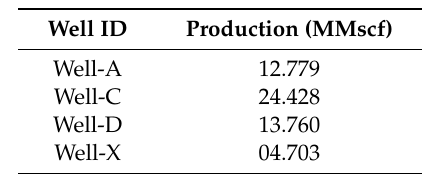
Figure 19. The time slices of ( a ) AI, ( b ) hydrocarbon saturation (Sat. HC) at Z = 2200, demonstrating the prospects within the target reservoir interval. Table 1. Production data from the study wells [2].